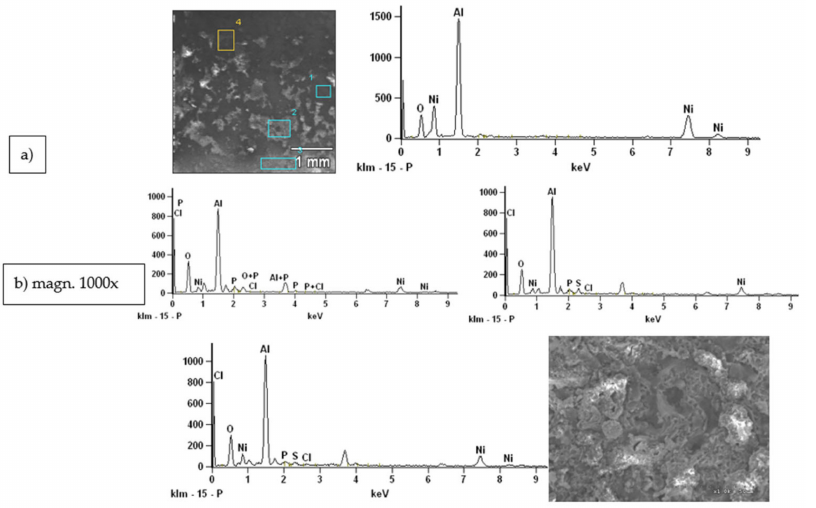
Figure 22. ( a ) Chemical composition of the NiAl intermetal surface in planes pt1, pt2, pt3 and pt4; ( b ) microscopic photo (SEM) of NiAl intermetal surface.